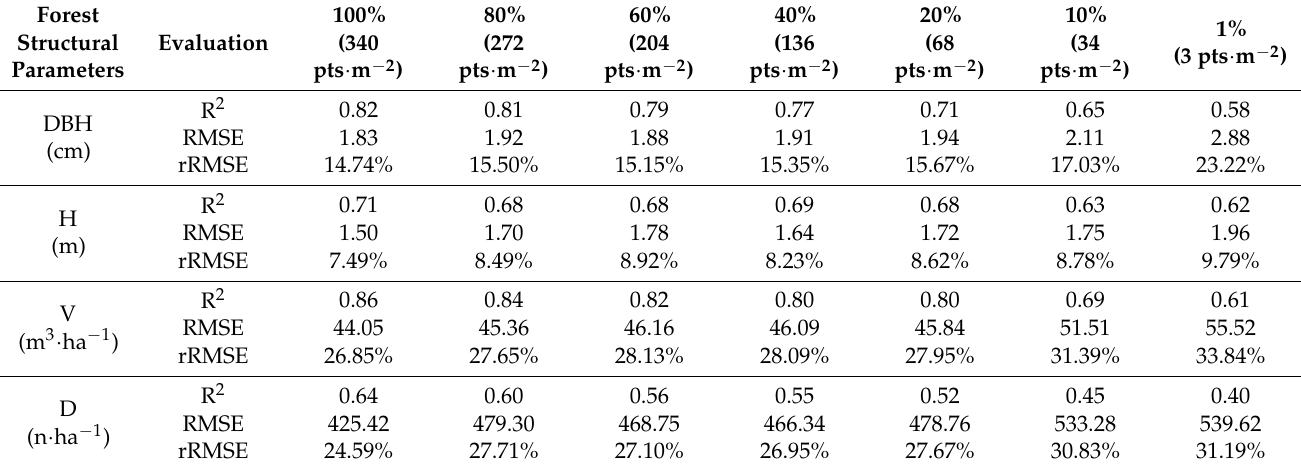
Table 5. Sensitivity analysis of estimation results by reducing UAV-LiDAR point